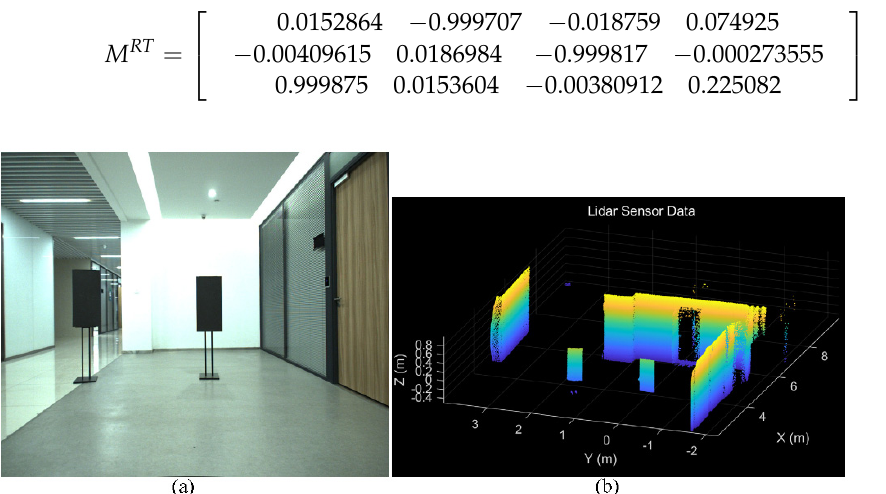
Figure 8. The processing procedure of the matched data point: ( a ) the color image; ( b ) the LiDAR point cloud data. In this case, two calibration boards made of low-reflectivity foam are used. In our project, we use the four corner points of the calibration board as the target points. The corresponding pixels on the image and LiDAR points are matched manually, then the matched data points are acquired.